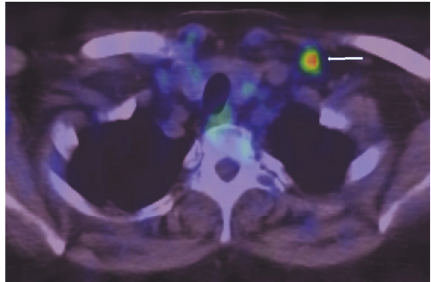
Figure 3: At the end of treatment. Imaging studies of the patient after having chemotherapy show interval regression of bilateral adrenal glands with both adrenal glands returning to normal size.